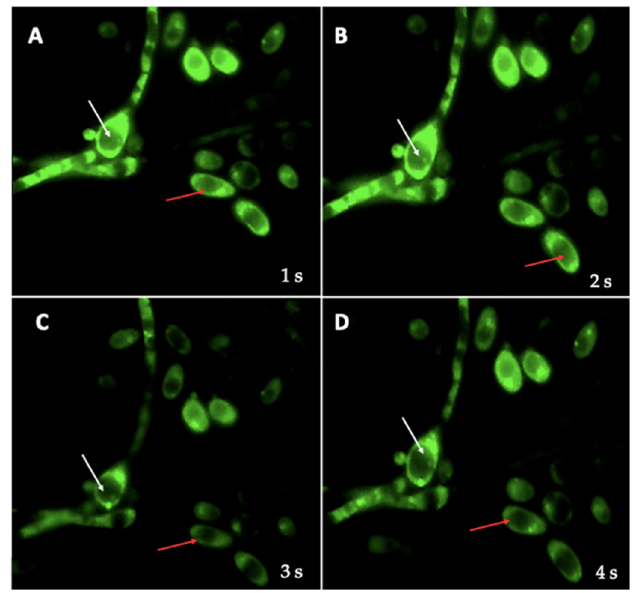
Figure 11. A, B, C and D correspond to a same microscopic field photographed at 1 s intervals. Cell viability, indicated by green fluorescence, of H. pylori harbored within C. albicans VT-3 after co-culturing them during 48 h. White arrows indicate yeast cells harboring intravacuolar H. pylori . The change in the position of H. pylori, at 1 s intervals, within the yeast can be observed (white arrow). In addition, the figure also shows yeast cells lacking intracellular H. pylori (red arrows).